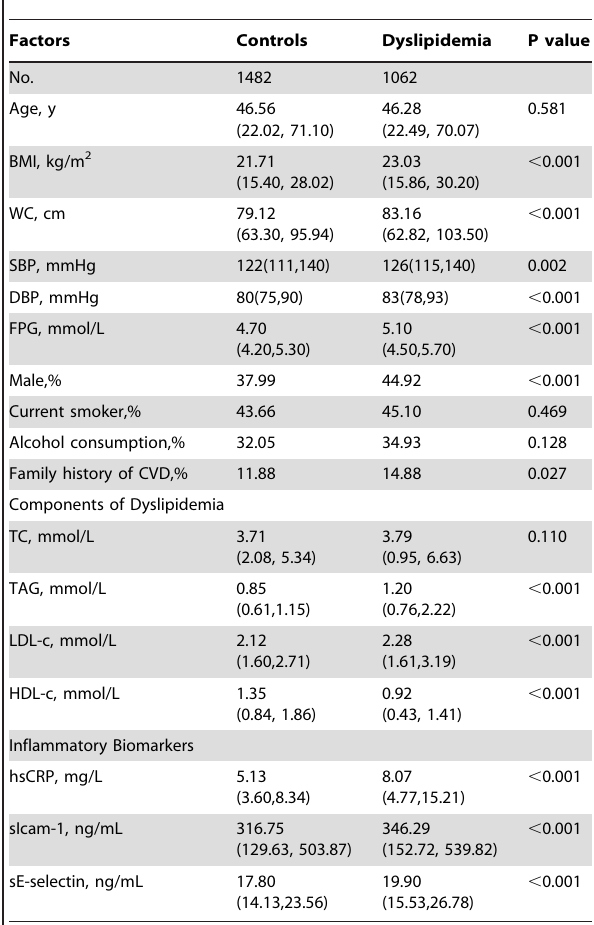
Table 1. Baseline Characteristics of 2544 Participants According to Category of Lipoprotein Abnormality.